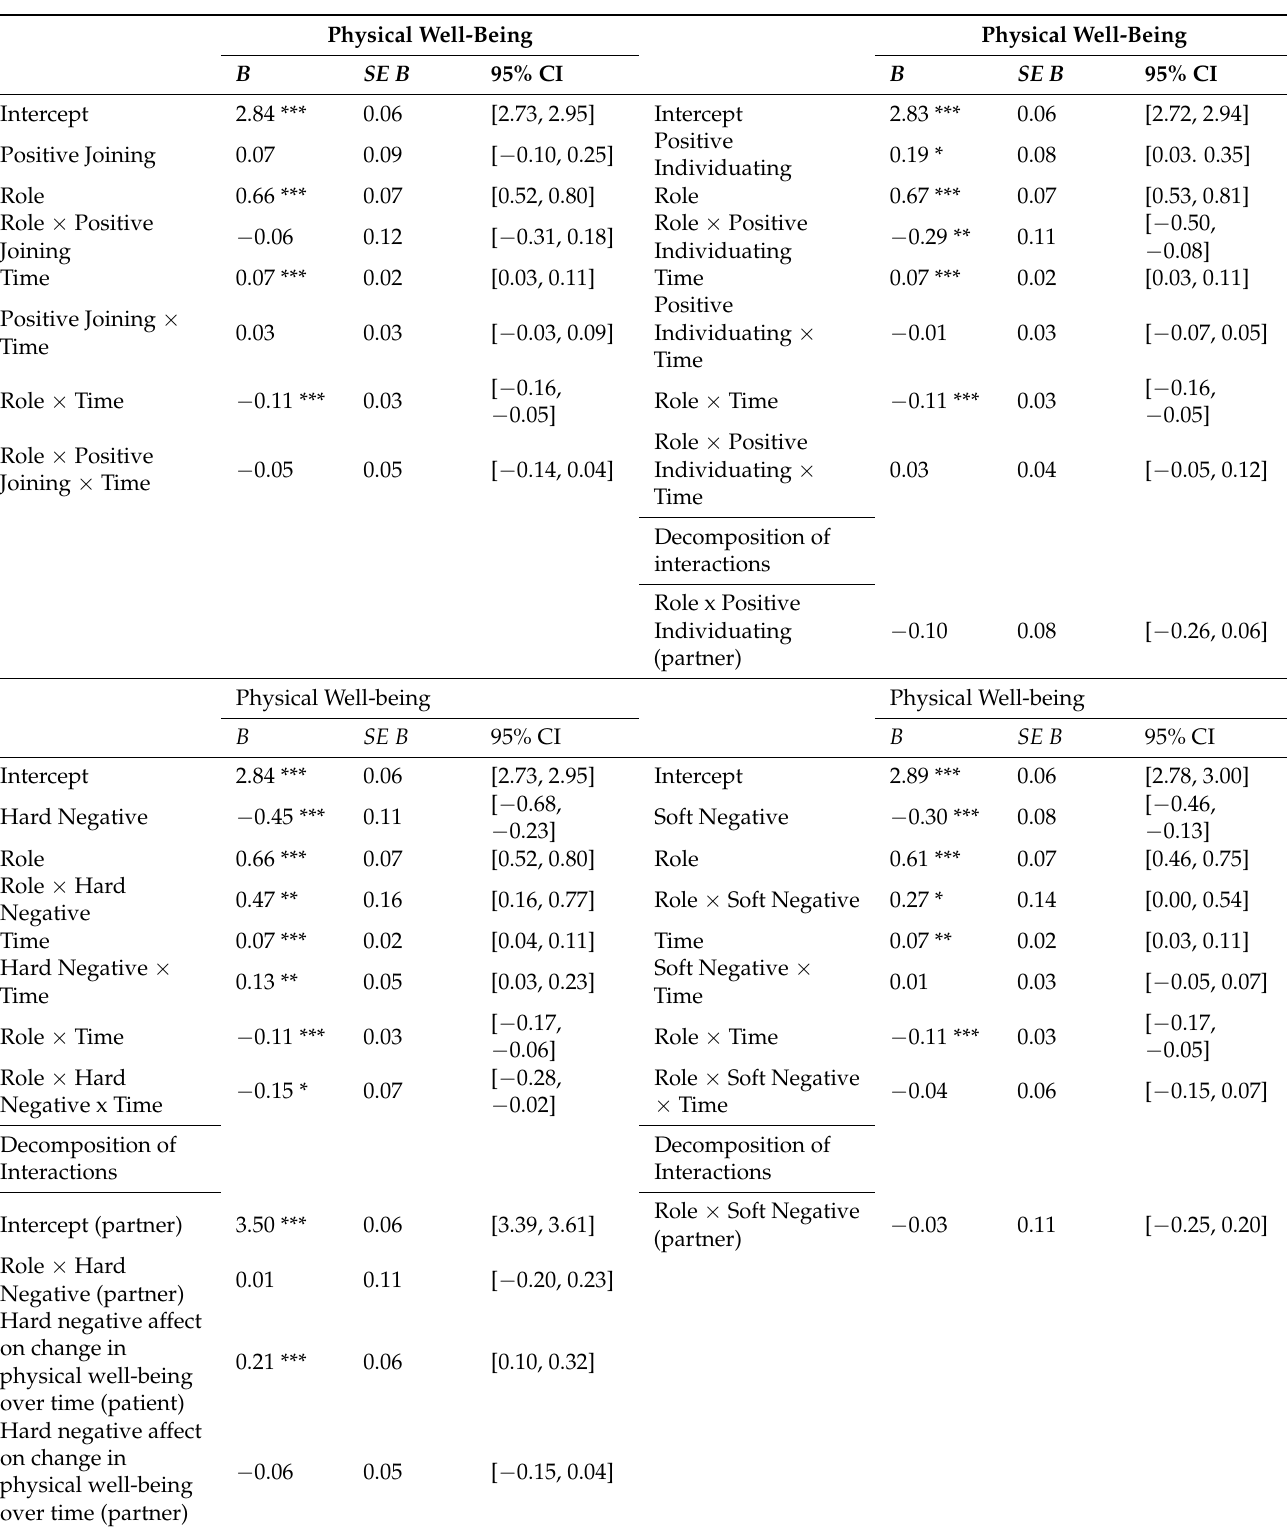
Table 6. Three-level mixed effect models of physical well-being, time, and affective expression for patients and